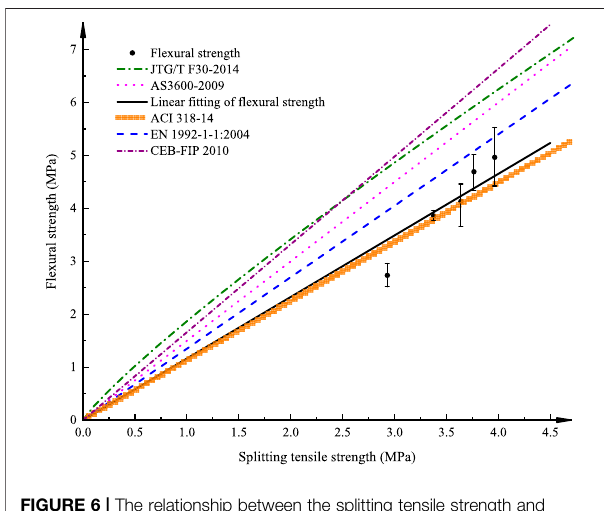
FIGURE 6 | The relationship between the splitting tensile strength and fl exural